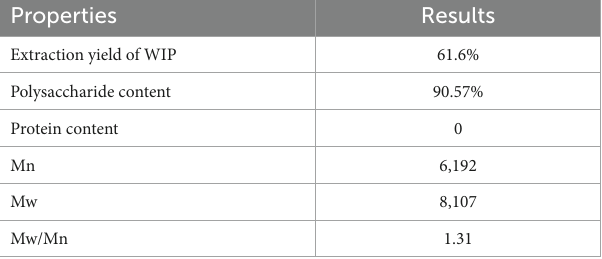
TABLE 1 Properties of water-insoluble polysaccharide from W. cocos (WIP).